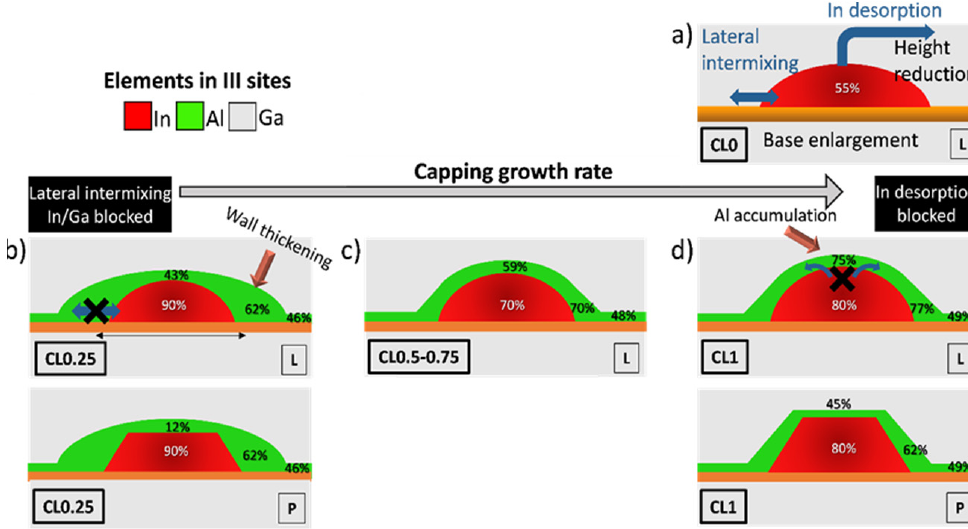
Figure 10. Schematic representation of the CGR effects in the GaAs/InAs/AlAs QD system for a ( a ) QD capped with GaAs (CL0), ( b ) covered by AlAs at 0.25 ML/s (CL0.25), ( c ) 0.5–0.75 ML/s and ( d ) 1 ML/s (CL1). “L” and “P” at the bottom right in each picture designate the lens and truncated pyramidal geometries. Average compositions for the QDs and the CL are indicated.